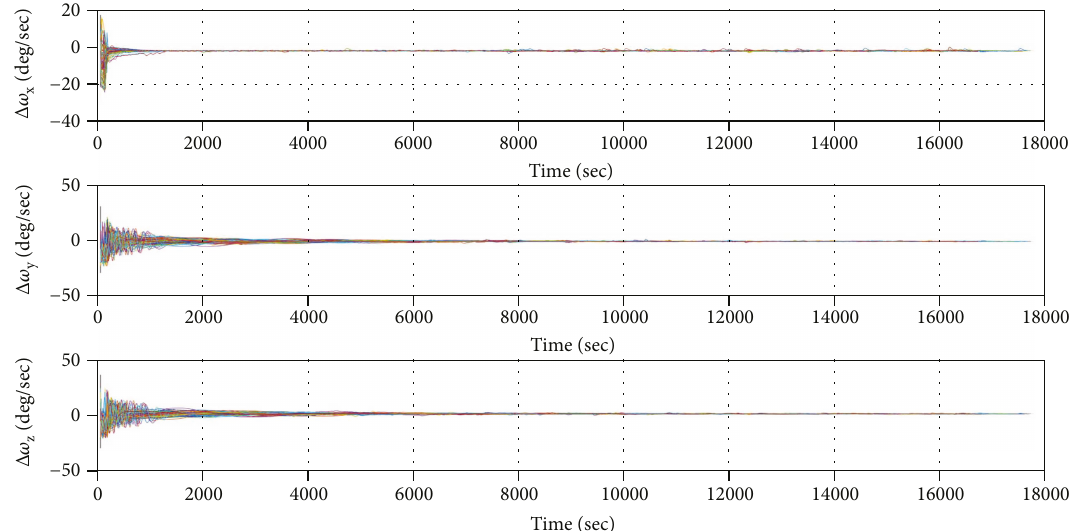
Δ ω Δ ω x , y , and z ) during the detumbling for 100 test cases simulated considering